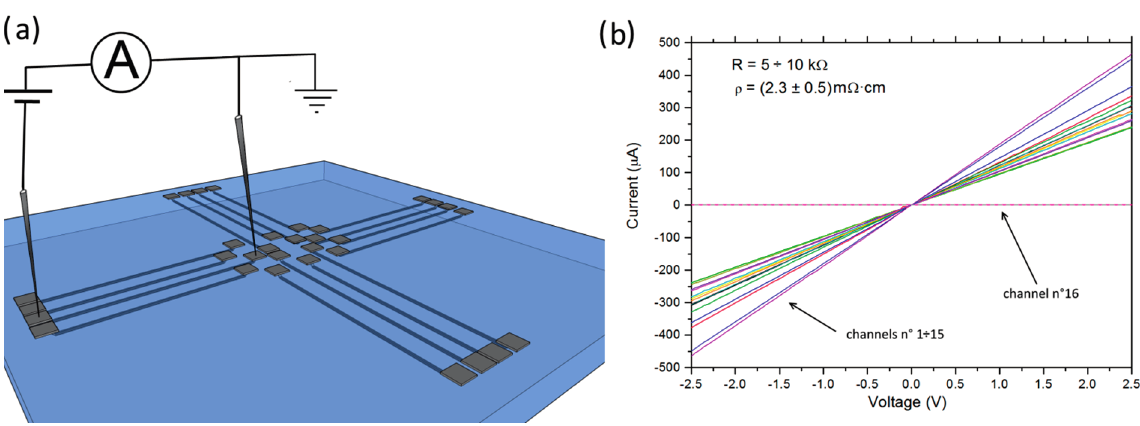
Figure 3. ( a ) 3D schematics of the diamond-based biosensor configuration during I-V measurements; ( b ) I-V characteristics of the 16 graphitic